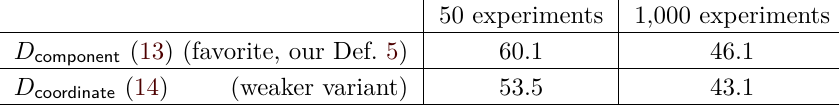
Table 1: Relative distinguishing margins ,as per (15), extracted from distinguisher compu- tations of Fig. 4 and